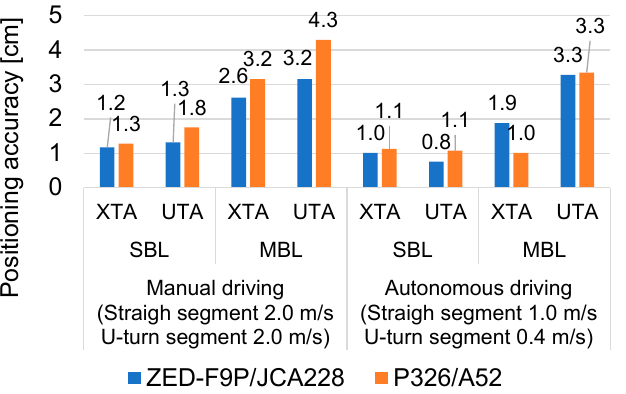
Figure 10. Dynamic RTK positioning accuracy of the test PDs in terms of RMS values of XTA and UTA.